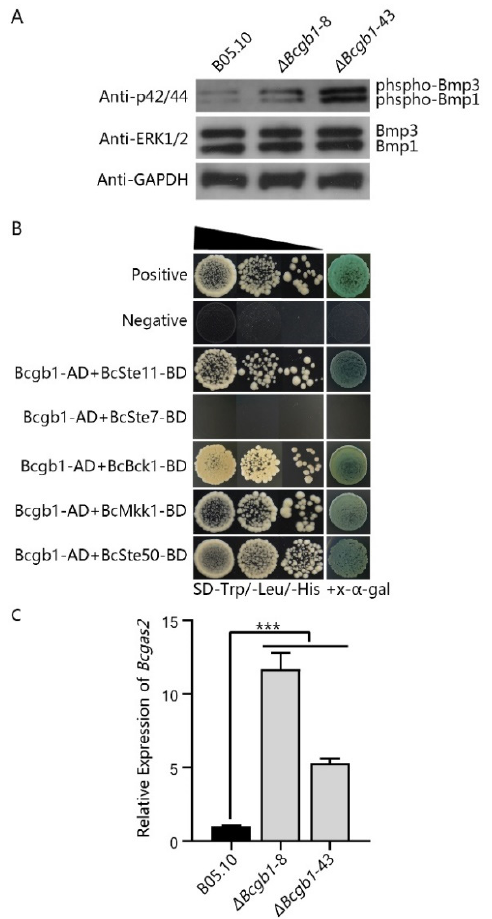
Figure 6. Bcgb1 negatively regulates the Bmp1 and Bmp3 MAPK pathway in B. cinerea . ( A ) Phosphory- lation level of MAPK (Bmp1 and Bmp3) in the Δ Bcgb1 mutants. Bmp1 and Bmp3 and their phosphory- lated proteins were detected using the ERK1/2 and phospho-p44/42 MAPK antibodies, respectively. The intensity of the phosphorylated Bmp1 and Bmp3 band for each strain is relative to that of the Bmp1 and Bmp3 band, respectively. ( B ) Yeast two-hybrid assay between Bcgb1 and BcSte11/BcSte7/Bmp1 and BcBck1/BcMkk1/Bmp3 cassette. The pGBKT7-53 and pGADT7-T pair of plasmids served as the positive control. The pGBKT7-Lam and pGADT7-T pair of plasmids served as the negative control. Yeast cells were drop-plated on SD-Trp/-Leu/-His with x- α -gal. ( C ) Transcript level of the Bmp1 MAPK-regulated gene Bcgas2 in the WT and the Δ Bcgb1 mutants of B. cinerea . *** p < 0.001.